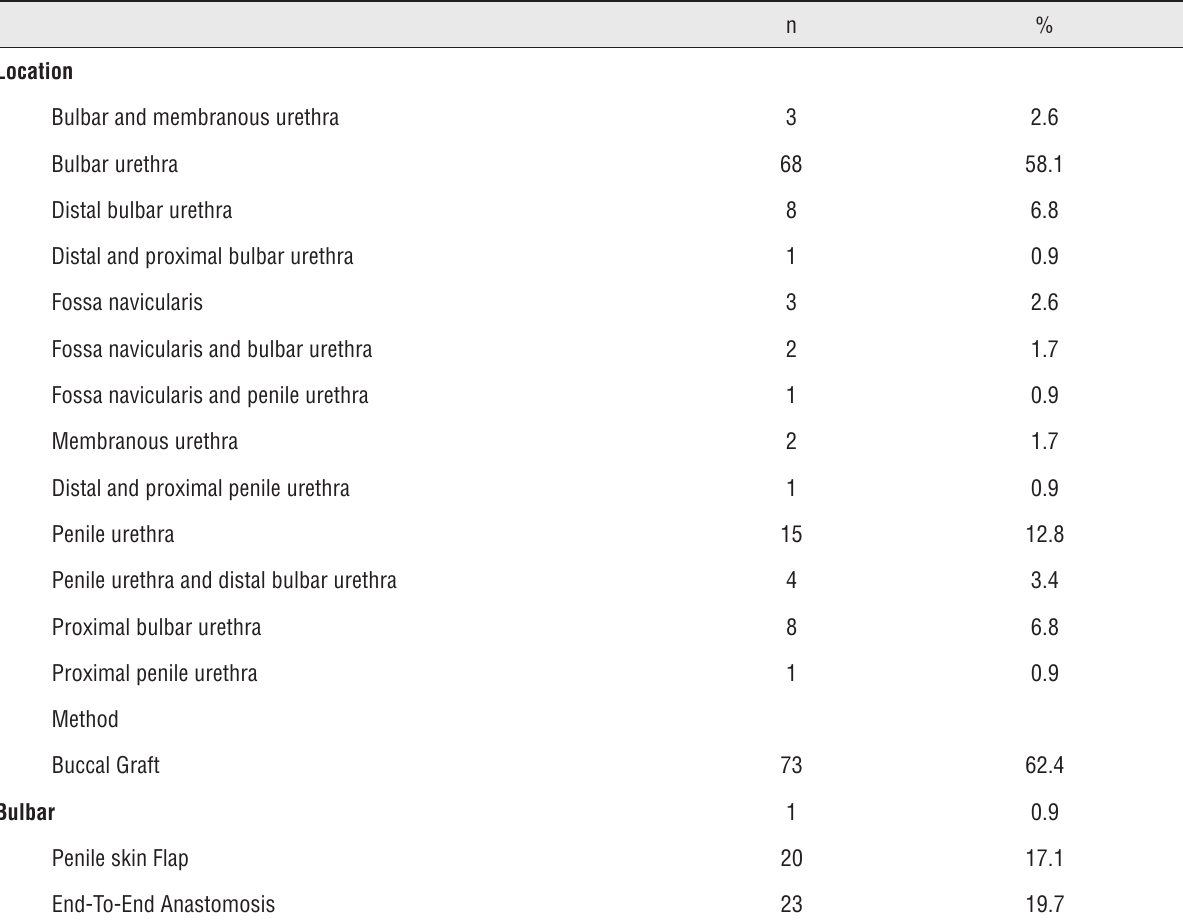
Table 1 - Stricture location and surgical method parameters.